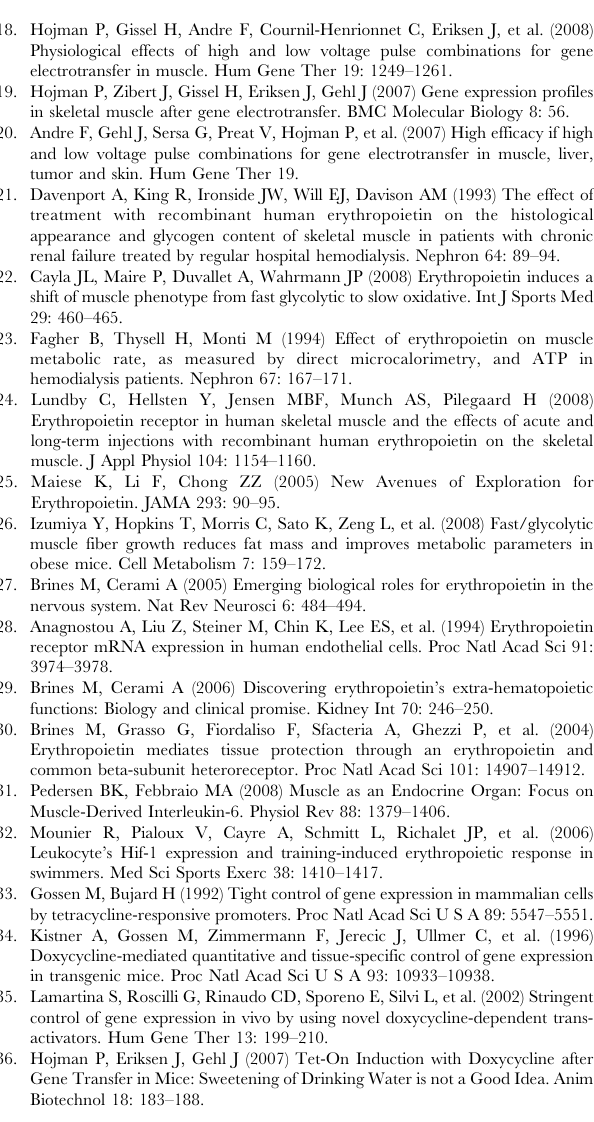
Figure S1 EPO administration induces large increases in Hgb levels. EPO was administered to groups of 8 mice either by DNA electrotransfer of 1 m g of EPO plasmid and each of the regulatory plasmids, pTet-On and pTetS into the right tibialis cranialis muscle; or by intraperitoneal injections of 10 m g/kg rhEPO. The mice were placed on either regular chow or a high-fat diet and means 6 SEM for each groups are depicted. A) Time course of hemoglobin levels, and B) serum iron contents measured 12 weeks after start of treatment. Statistical significance was tested by Student’s t-test with Bonferroni corrections for multiple testing. * indicates significance at p , 0.05, while ¤ indicates significance at p , 0.01. Figure S2 Weight of liver and heart. Twelve weeks after DNA electrotransfer livers and hearts from EPO transfected mice were weighed, and means 6 SEM for groups of 8 mice are shown. Statistical significance was tested by Student’s t-test with